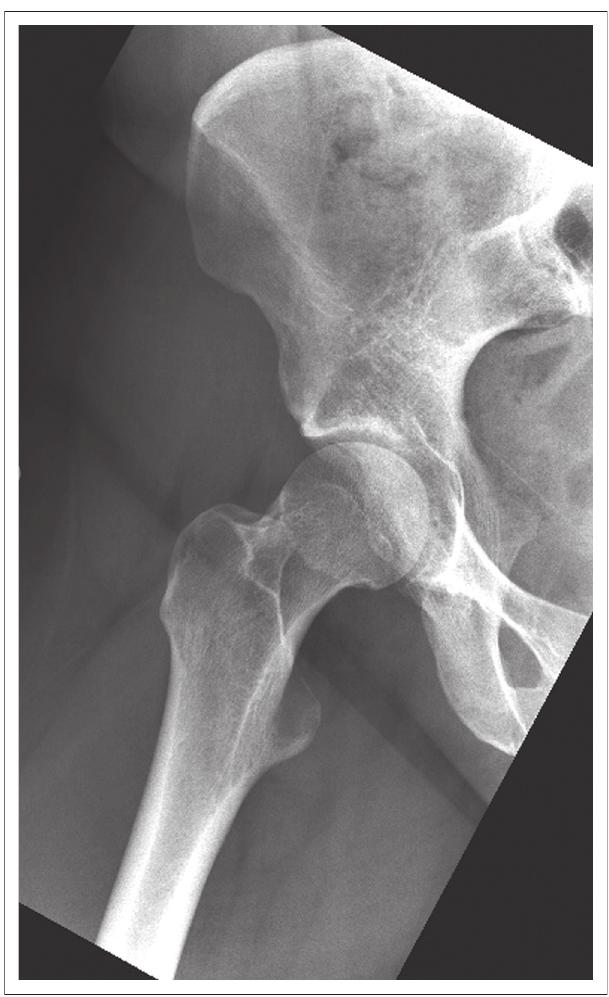
FIGURE 1: Plain radiograph of the right hip.